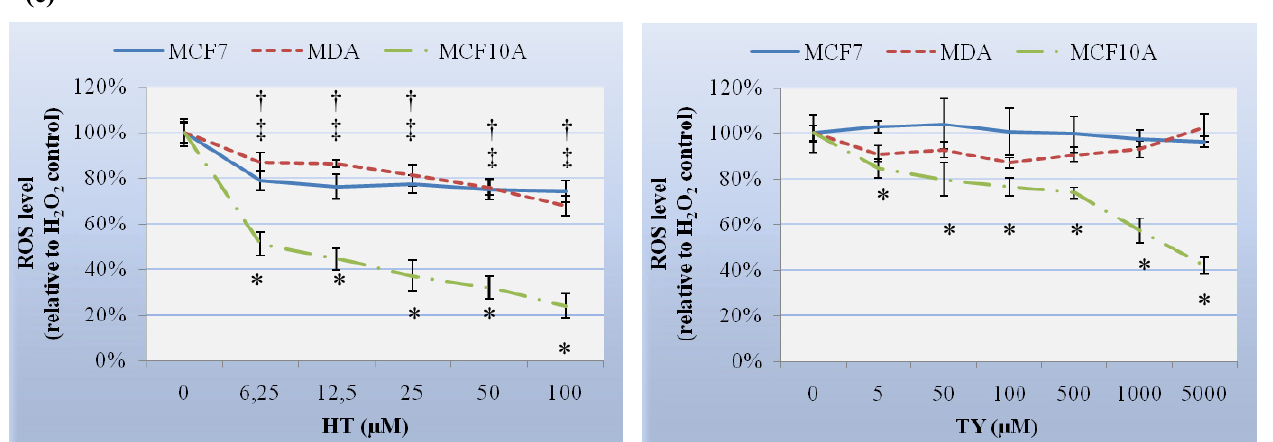
Table 2. Oxidative inhibition in MCF10A cells. IC for antioxidant inhibition of basal or H